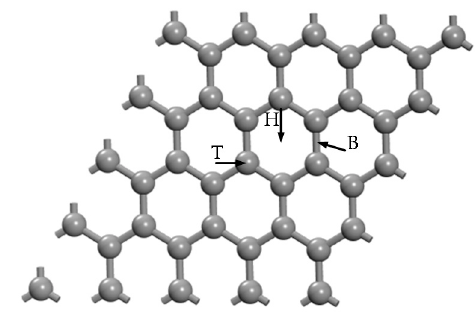
Figure 2. Three potential doping sites of graphene.